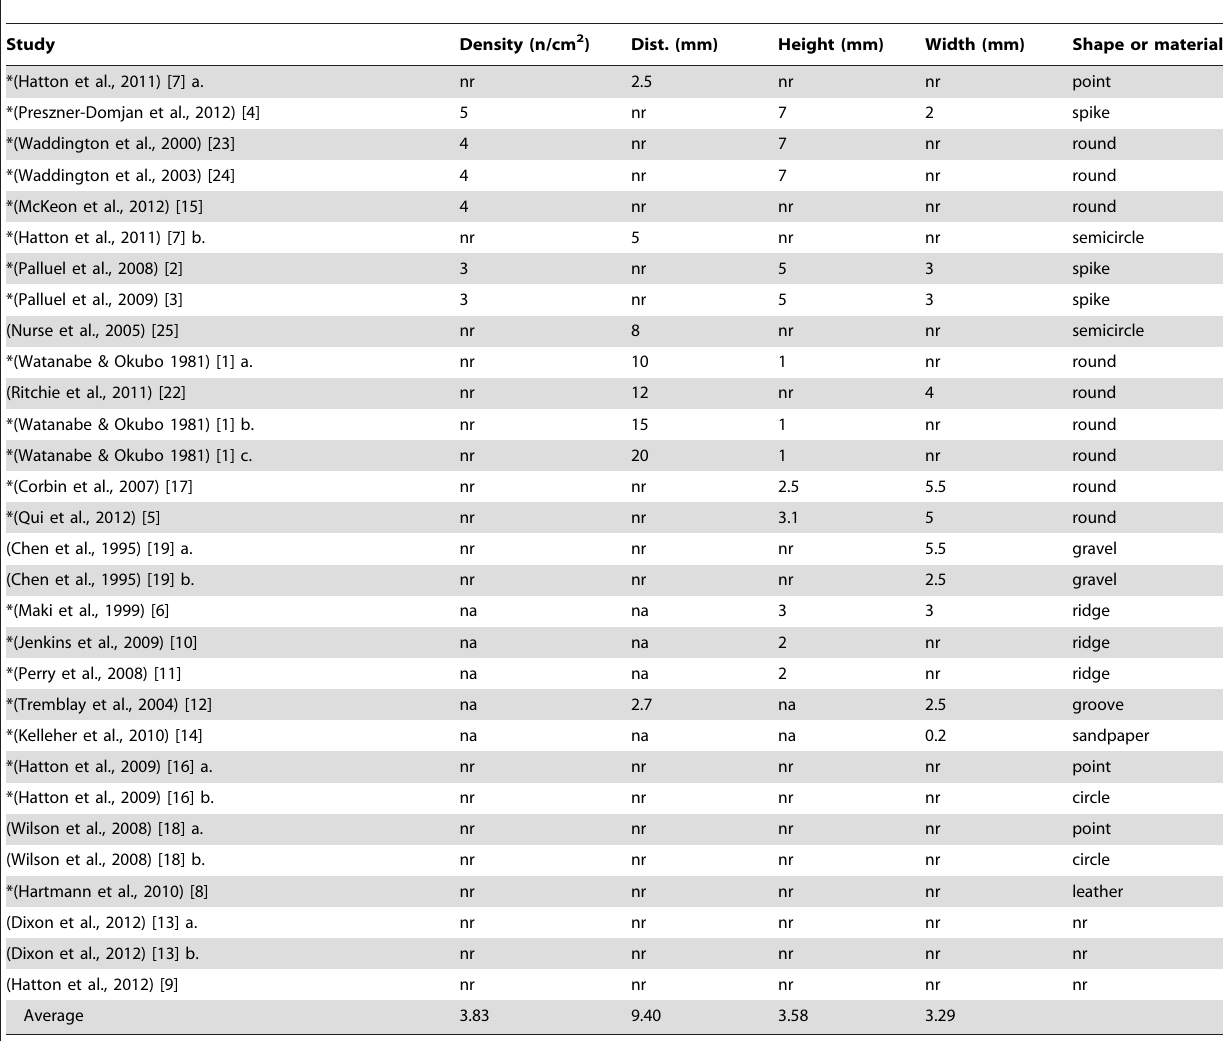
Table 2. Texture Dimensions and